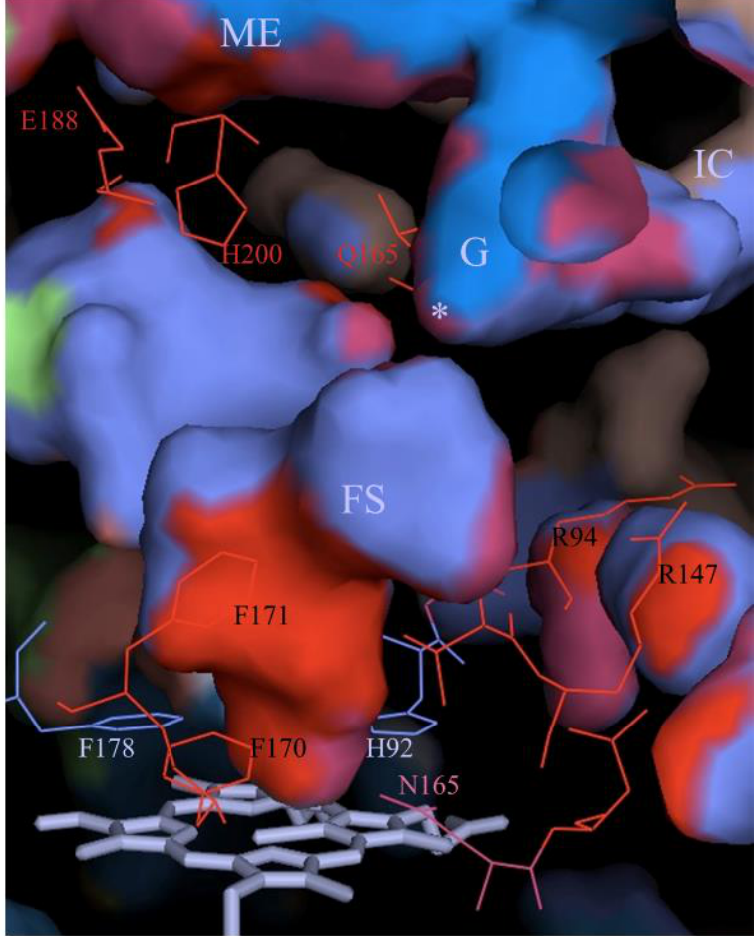
Figure 7. Coordinated amino acid movement in the main channel of CAT-1. Shown are the internal surfaces of the main channel of the main entrance (ME), the gate (G), the asterisk indicating the interruption between the gate and the FS by Ser198, the final section (FS), and the active site at His92 and Asn165. Marked in red and pink lines are the amino acid residues that present coordinated movement (red indicates the most coordinated). Shown in light blue lines are the less mobile amino acid residues. The heme is depicted with gray sticks. The interconnecting channel (IC) connects the gates from the P-axis related subunits.